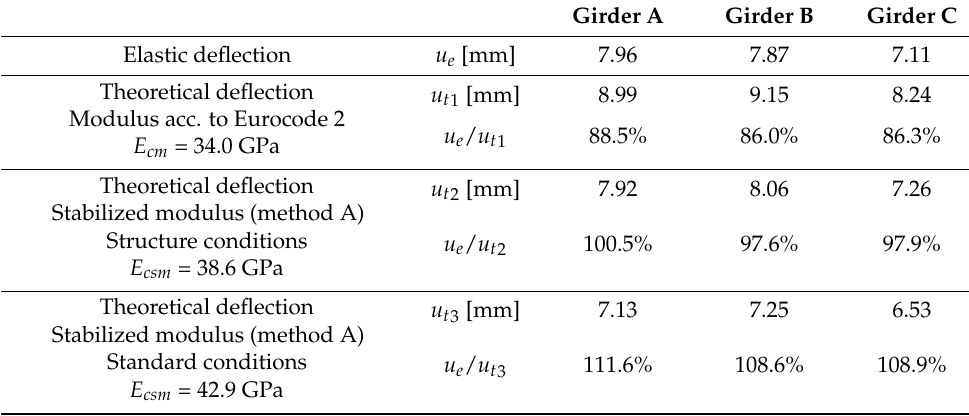
Table 5. Summary of the results of test load and numerical